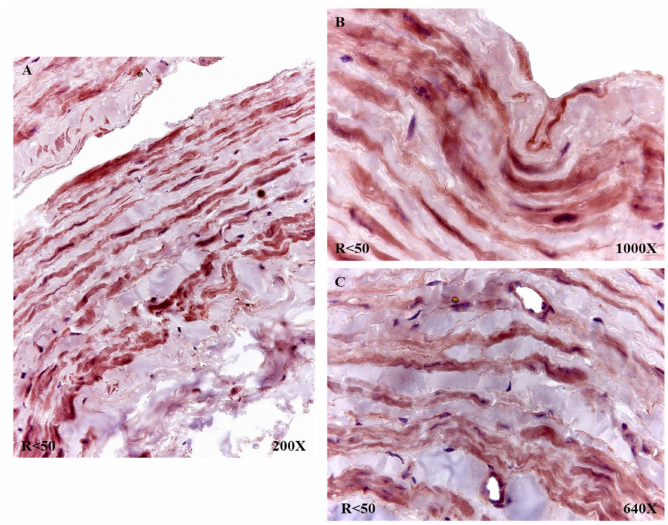
Figure 11. Fibulin 4 protein expression in patients with reflux younger than 50 years (R < 50). Fibulin 4 expression is shown in all three tunics ( A ), smooth muscle fibers ( B ), detail of elastic fibers and blood capillary ( C ).